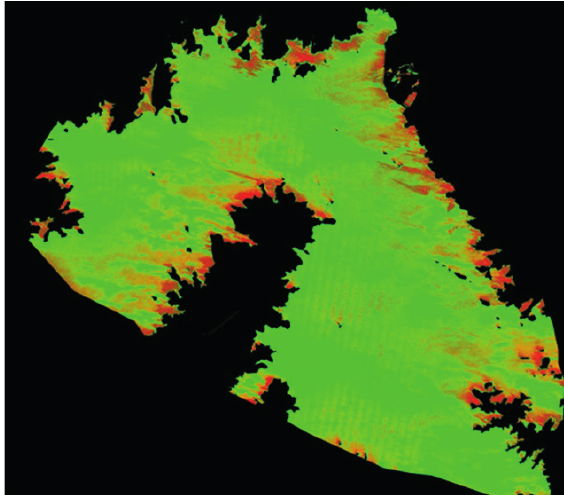
Figure 3 - The processed image of the principal open area of the Castanhão reservoir in 2012, showing chlorophyll content dispersed through the central